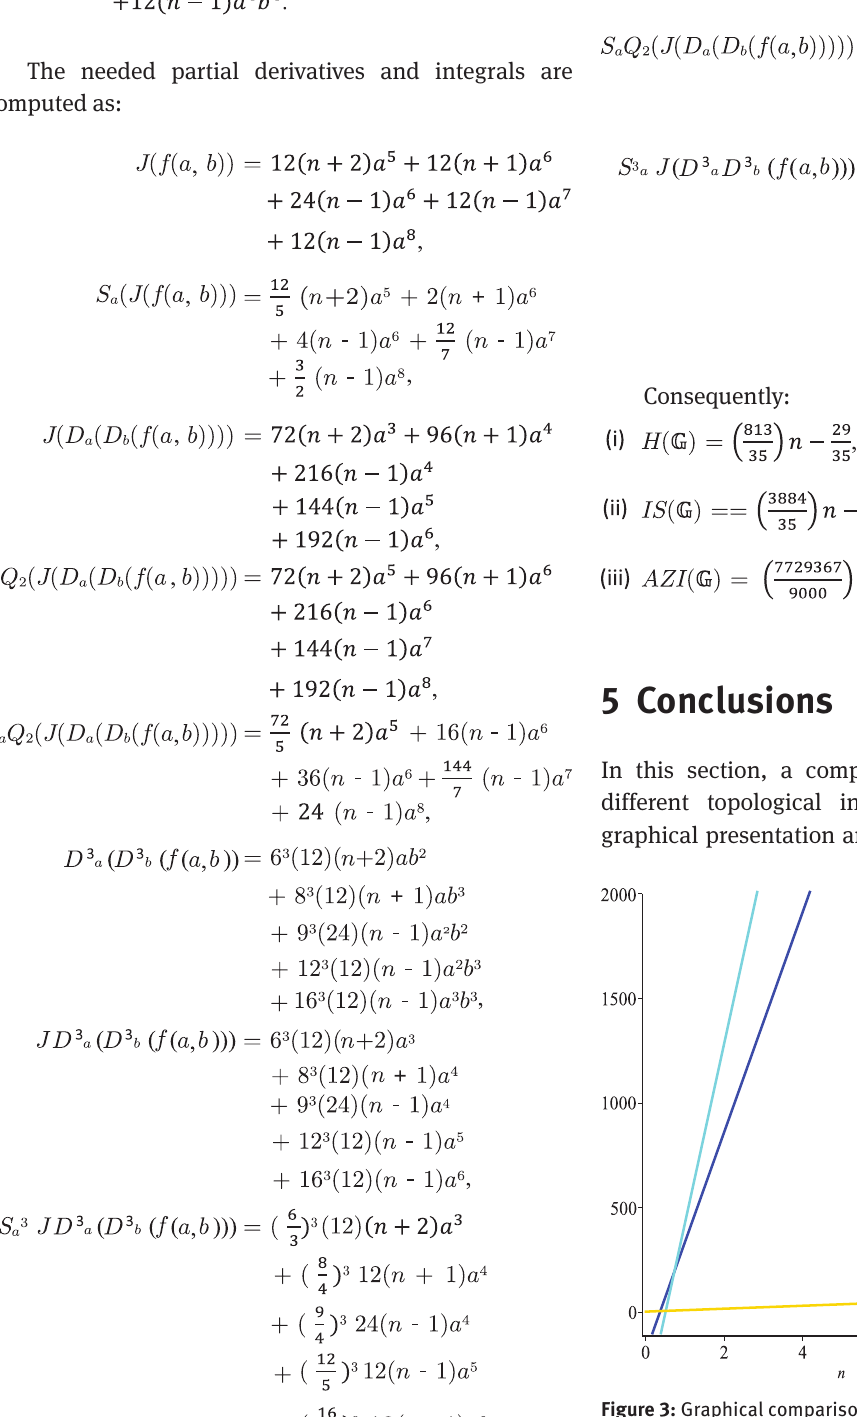
(G), M (G), and MM (G) are 1 2 2 ( n 1